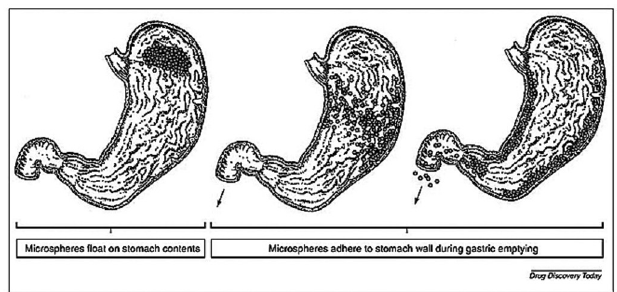
FIGURE 4 - Mechanism of gastroretention of floating microspheres having mucoadhesive polymer (Stanley,